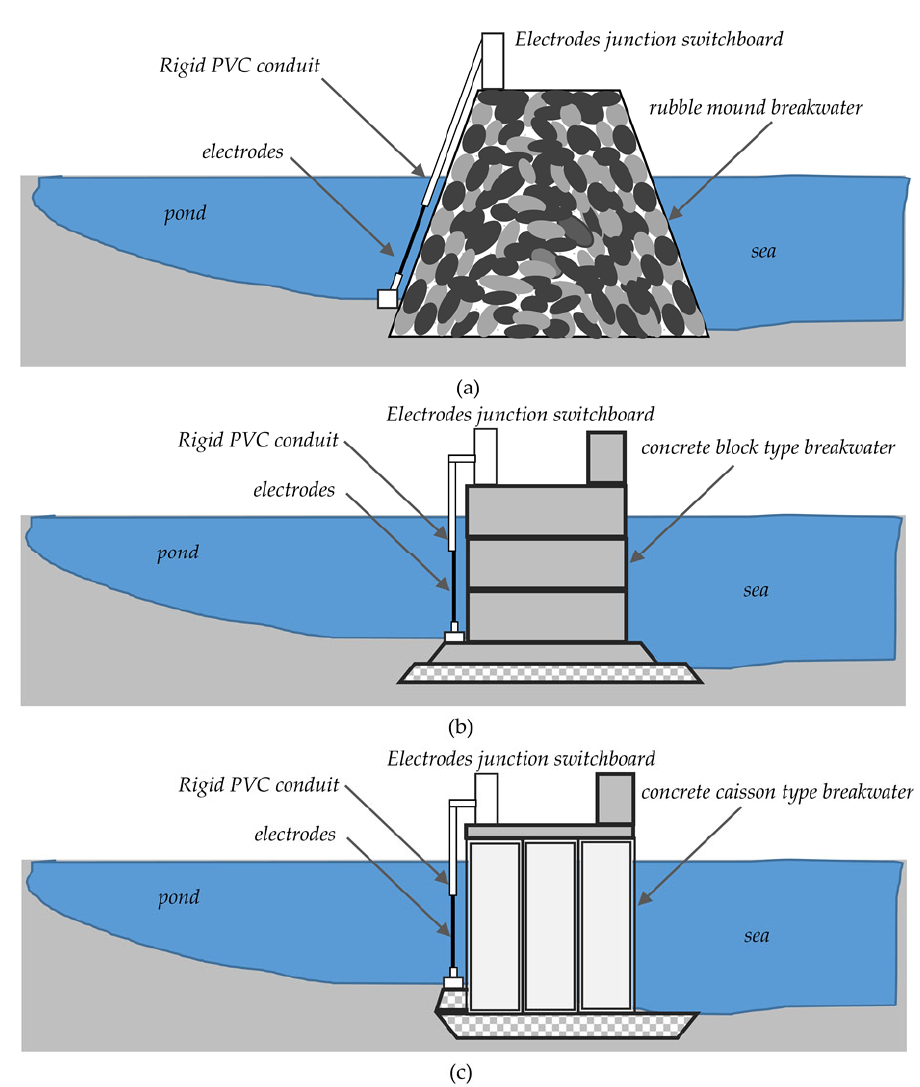
Figure 10. Shoreline electrode station with ( a ) rubble mound breakwater, ( b ) concrete block breakwater, ( c ) concrete caisson breakwater.